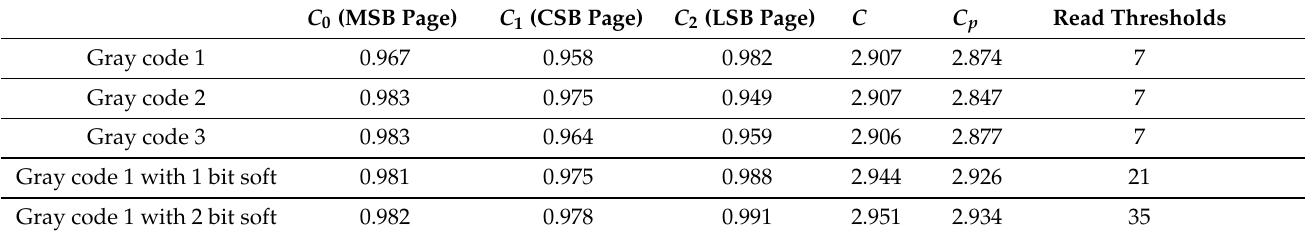
Table 2. Page capacities of a TLC at EOL depending on the